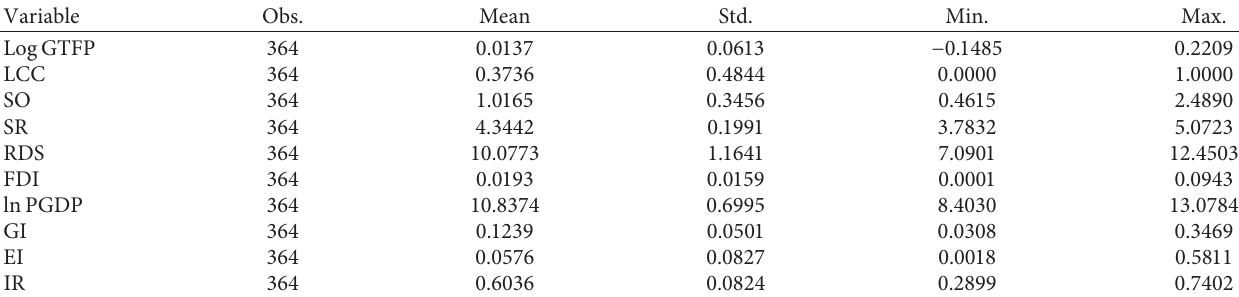
Table 3: Descriptive statistics table.